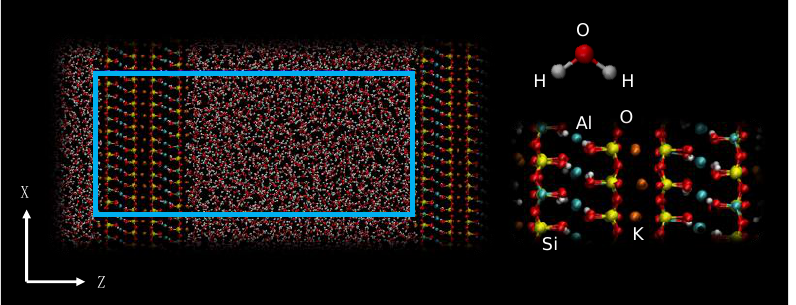
Figure 1. A snapshot of the initial state of the calculation system (H 2 O/muscovite system). The area outside the blue line is the area duplicated by the periodic boundary conditions. Each atom is col- ored differently — oxygen: red; hydrogen: white; aluminum: cyan; silicon: yellow; potassium: or- ange.